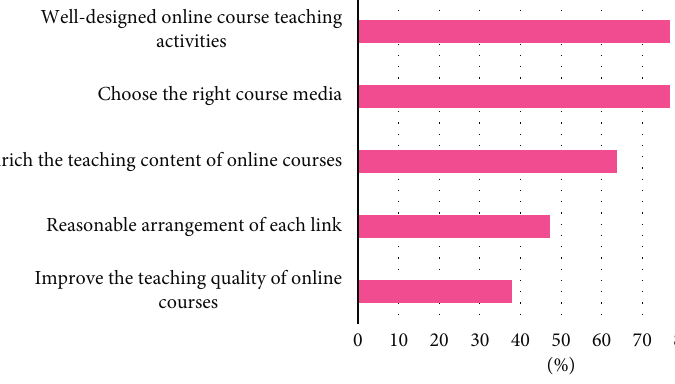
Figure 6: University interactive mathematics experiment